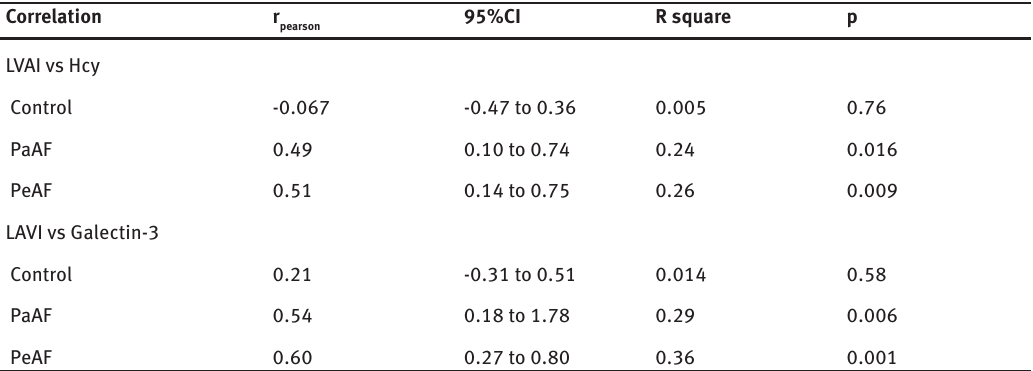
Table 4: Correlation between serum Hcy, Galectin-3 concentration and LAVI. Correlation